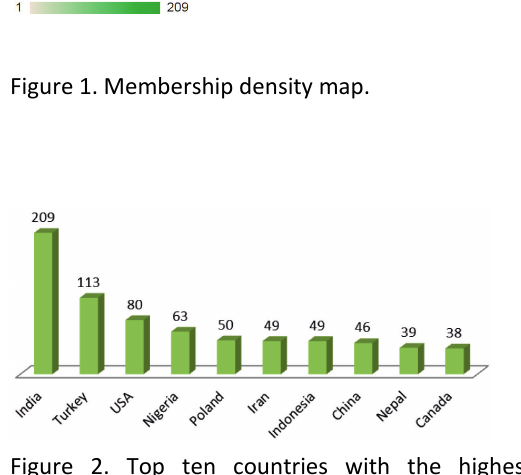
Figure 2. Top ten countries with the highest number of members in 2016.